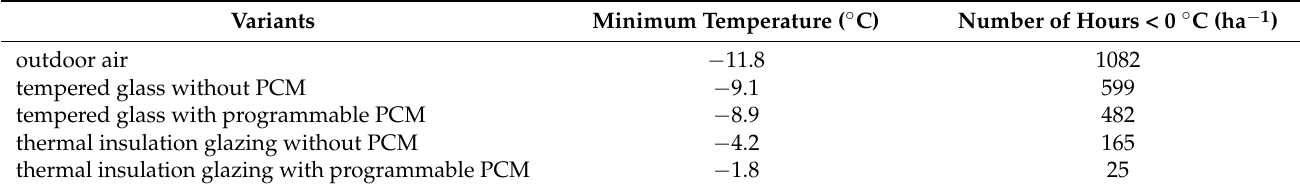
Figure 7. Comparison of the time dependence of indoor air temperatures for single (red) and thermal insulation glazing (blue). Table 2. Minimum temperatures and number of hours below 0 °C during the year.